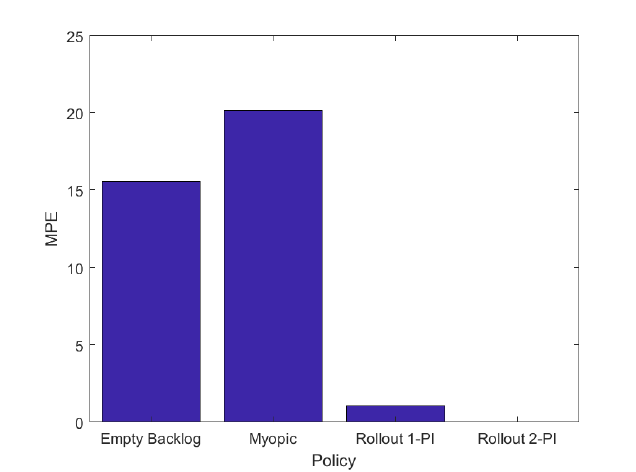
Figure 4. Mean percentage error increment in energy consumption for the Empty Backlog, Myopic and Rollout, with one and two policy improvement steps, policies, compared to the OPI